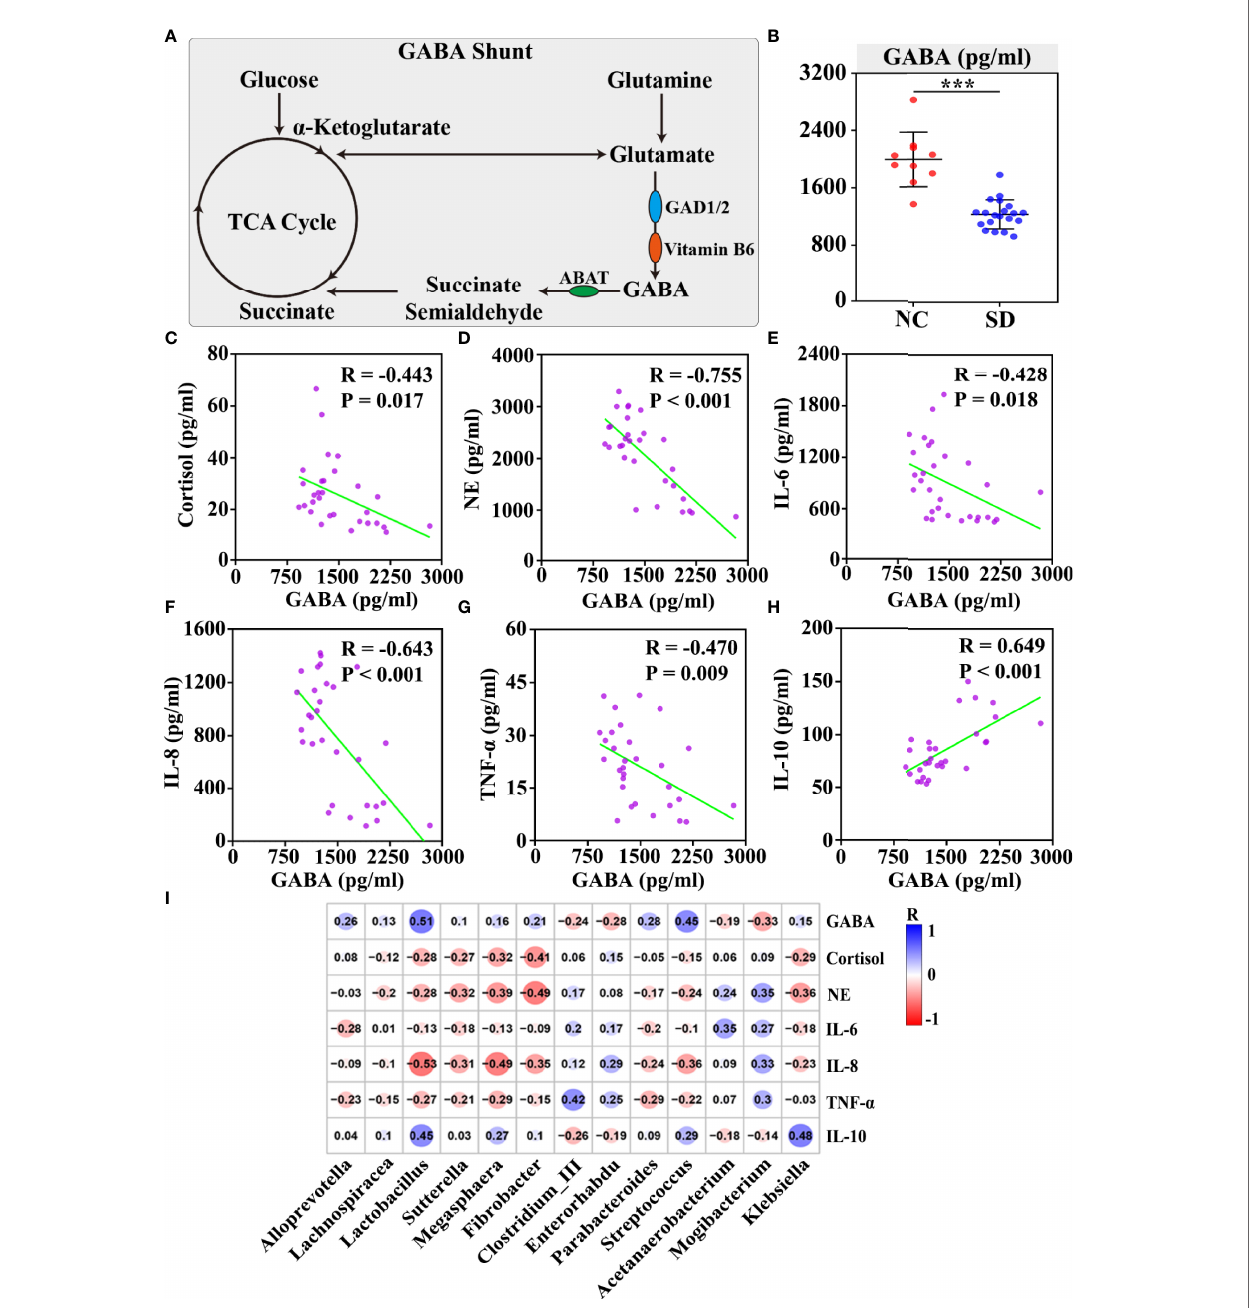
FIGURE 4 | The correlation between plasma GABA and sleep deprivation (SD) altered stress hormones and gut microbiota disorders. (A) Schematic of the GABA shunt and related enzymes. (B) The concentration of serum GABA was measured by ELISAs. Plasma GABA was negatively correlated with cortisol (C) , norepinephrine (D) , IL-6 (E) , IL-8 (F) , and TNF- a (G) , but positively associated with the anti-in fl ammatory cytokine IL10 (H) . (I) The correlation between thirteen SD altered differential genera and plasma stress hormones and in fl ammatory cytokines was shown in the correlation matrix. The blue and red color indicated positive and negative correlation, respectively. The correlation strength was signi fi ed by color intensity. The greater the color intensity, the stronger the correlation. Differences were denoted as follows: *** p < 0.001. TCA cycle, tricarboxylic acid cycle; GAD, glutamate